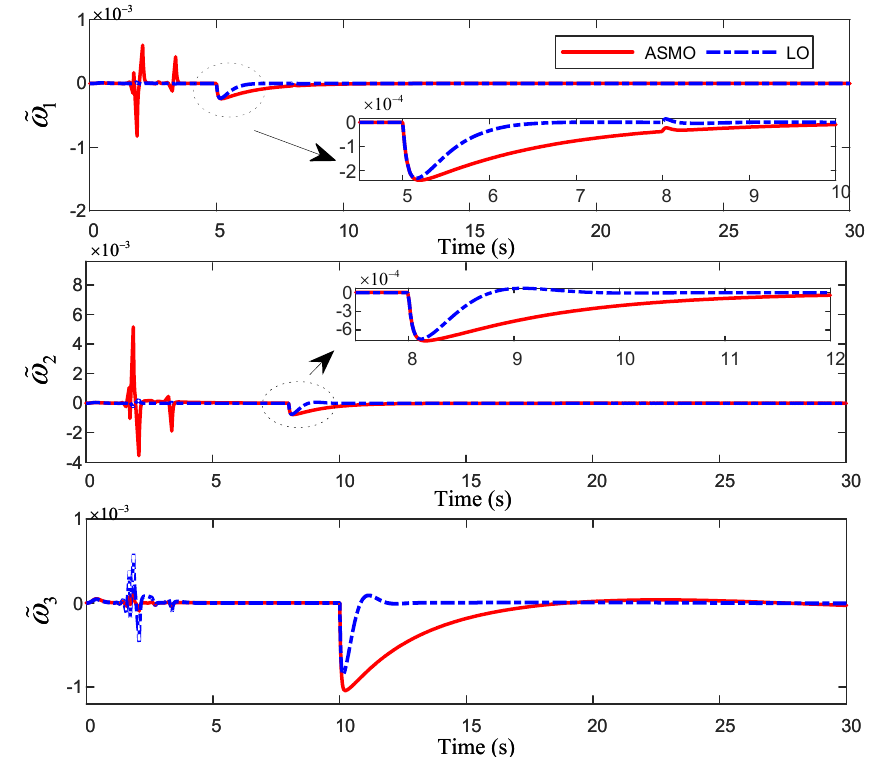
Figure 4. The estimation error of angular